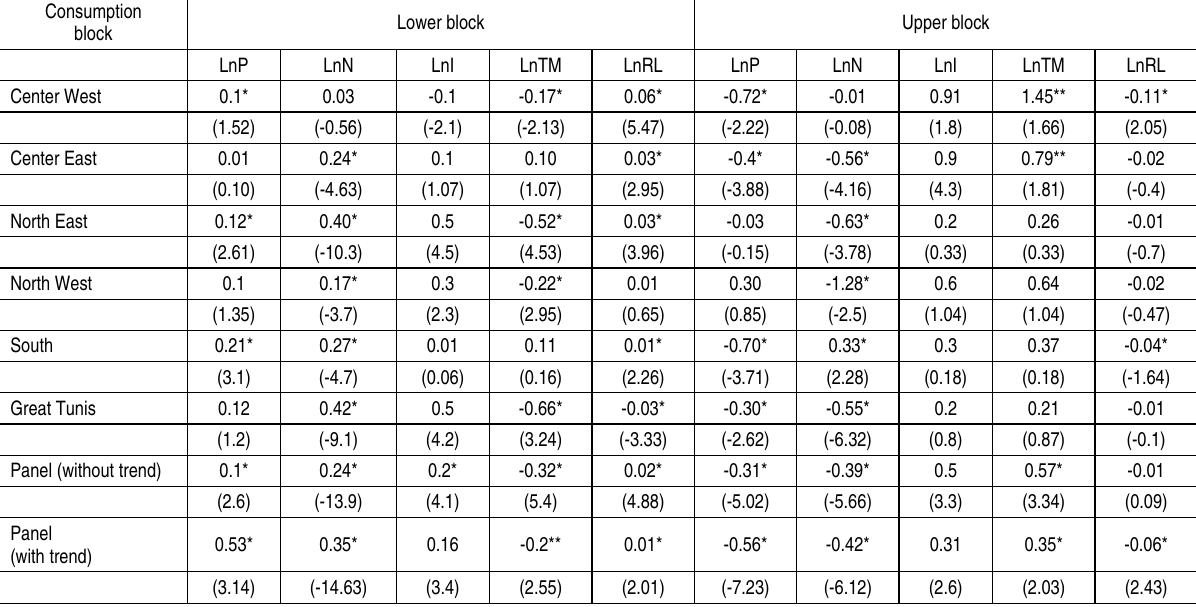
Table 6. FMOLS estimation